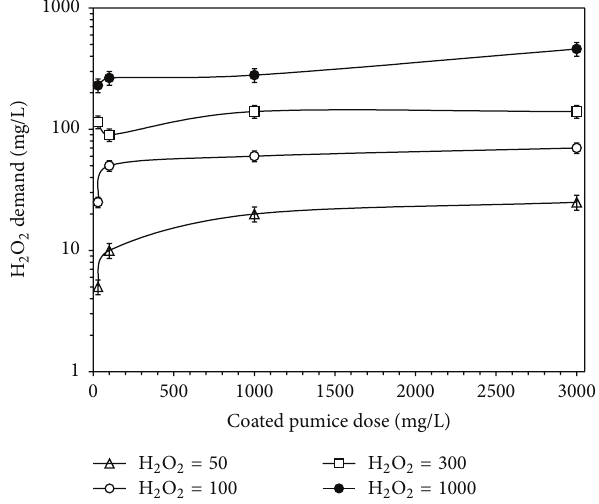
Figure 5: The effects of iron oxide-coated pumice and hydrogen peroxide dosages on hydrogen peroxide demands in MB water. < 63 𝜇 m iron oxide-coated Isp pumice: peroxide dosages in the legend are in mg/L. Error bars indicate the 95% confidence intervals.